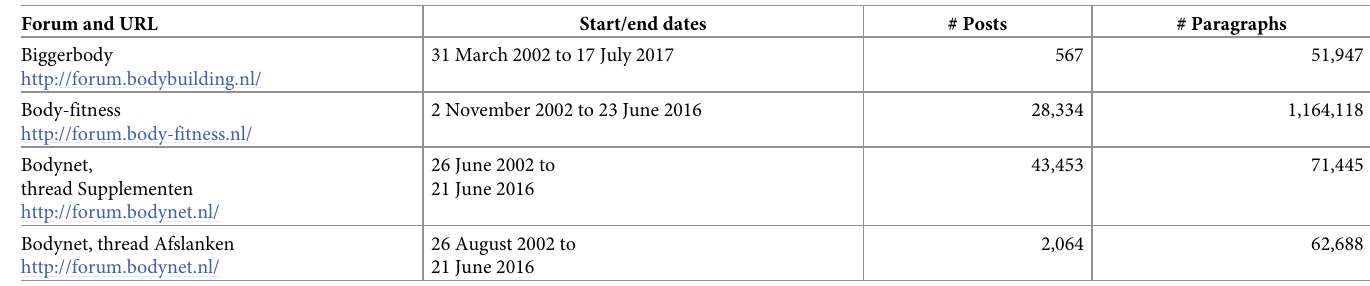
Table 1. List of the forum data used in this